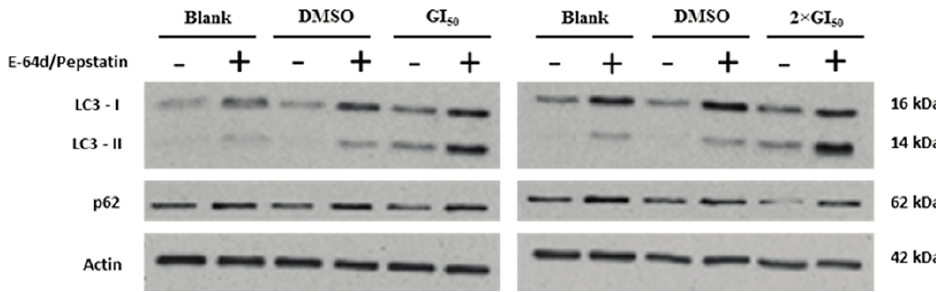
Figure 4. Effect of co-treatment with G. lucidum methanolic extract together with E-64d/pepstatin in LC3-II and p62 levels, analyzed by Western blot. Cells were treated for 48 h with medium (Blank), with the solvent (DMSO) or with the extract (GI 50 and 2 × GI 50 concentrations), together with (or without) E-64d/pepstatin (15 µg/mL). Actin was used as loading control. Results are representative of 3 independent experiments.